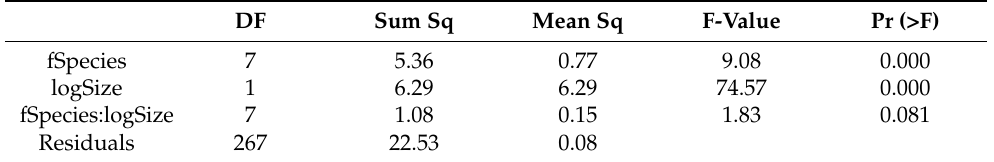
) = β + β 0 1 Species M a